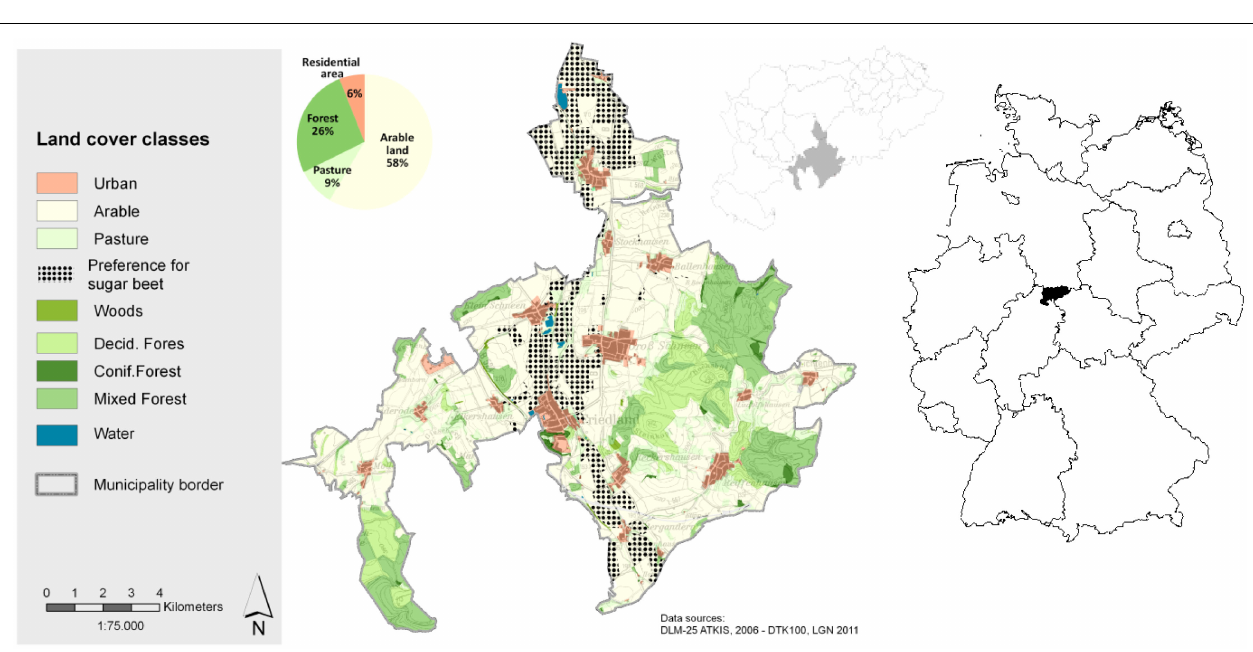
r egional scale, by example of the small catchment area of the river Dramme. Here, the parameterization for poplar SRC, derived on the plot level, is used together with other land use types to investigate local and regional changes of hydrological properties for different scenarios of SRC cultivation. Scenarios were selected for different area fractions converted from agriculture to SRC,